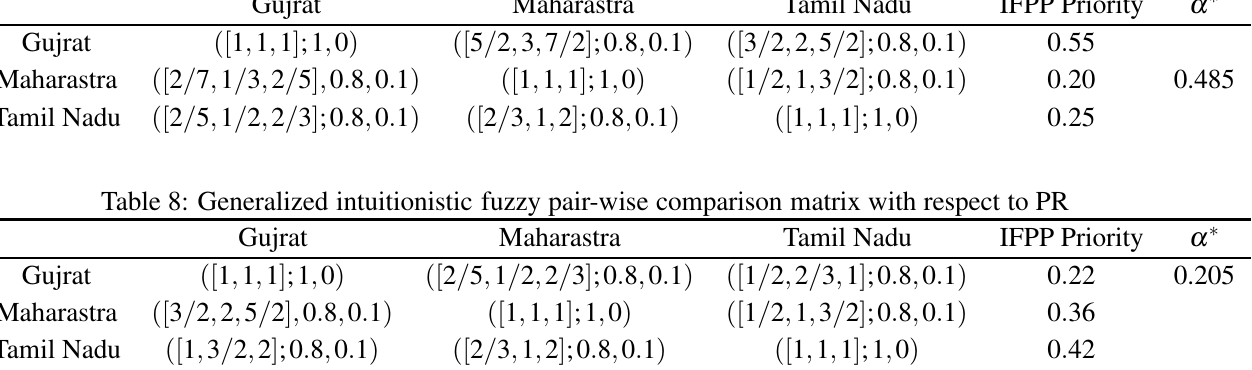
Table 7: Generalized intuitionistic fuzzy pair-wise comparison matrix with respect to CEA Gujrat